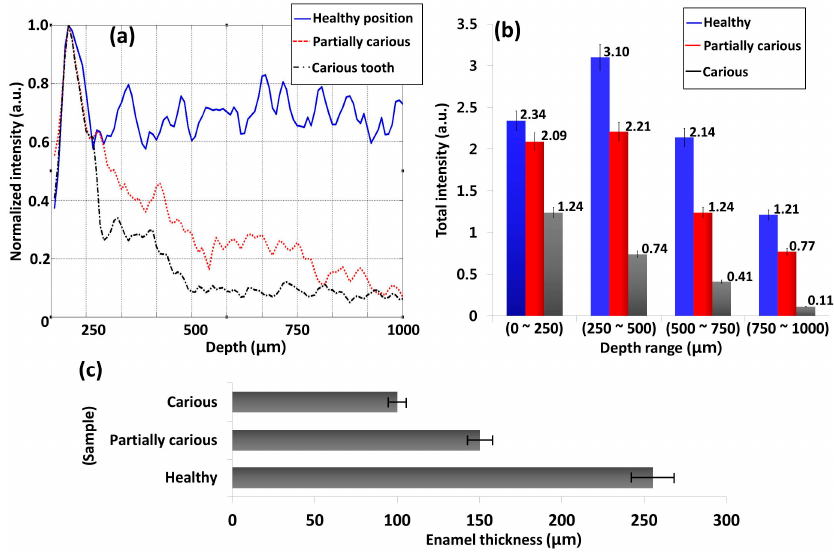
Figure 4. The quantitative evaluation method for healthy, partially demineralized, and completely demineralized (carious) molar tooth samples. ( a ) A-scan depth profiles of healthy, partially demineralized, and carious samples; ( b ) The total intensity fluctuation of healthy, partially demineralized molar, and completely demineralized (carious) molar tooth samples for the entire visible depth range of 1 mm with a gap of 250 μ m depth range; ( c ) The depth direction enamel thickness values of the healthy, partially carious, and carious